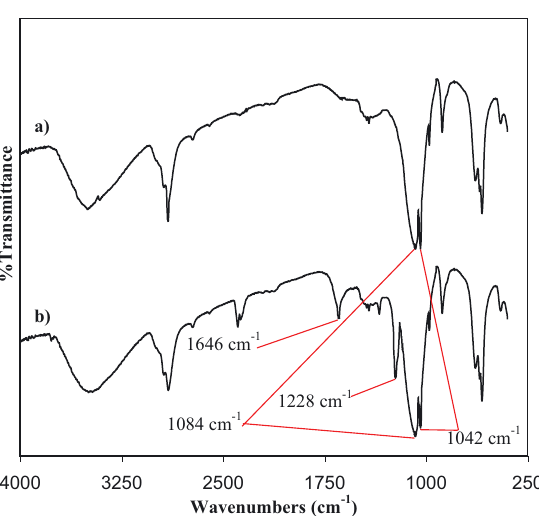
Figure 6. FTIR spectra of (a) pure EG, (b) sample S